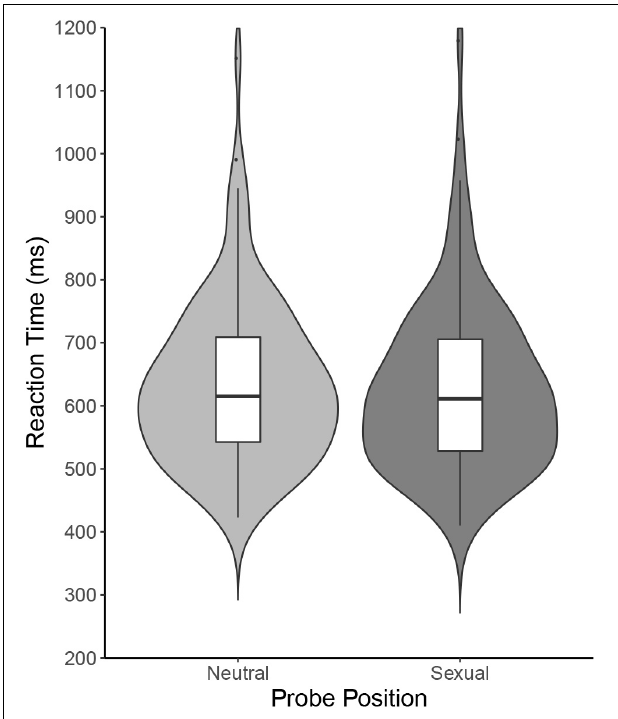
FIGURE 2 | Dot-probe task: Reaction times (ms).